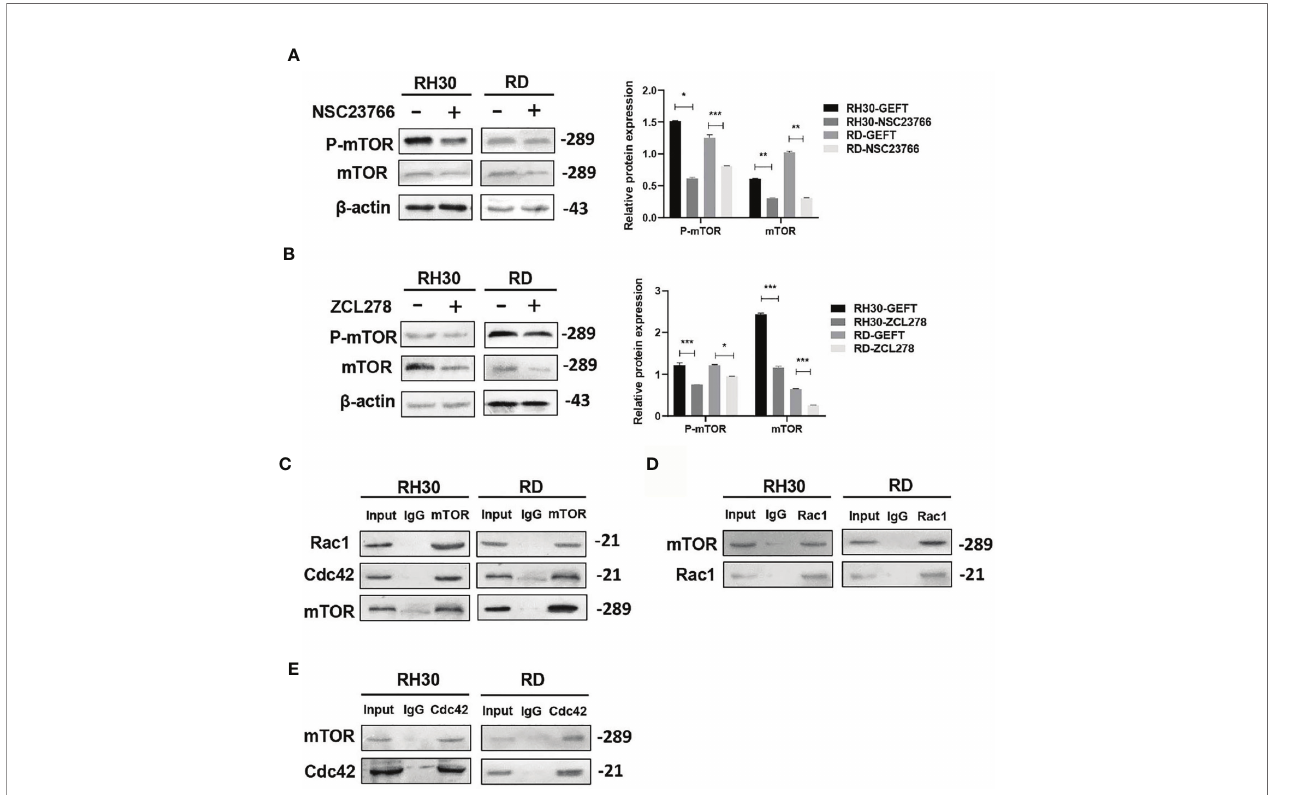
FIGURE 5 | mTOR can be regulated by Rac1/Cdc42. (A, B) The Rac1 (A) and Cdc42 (B) inhibitors were added to the RMS cells. p-mTOR and mTOR were detected by Western blot, and b -actin was used as a control. (C) The Rac1 and Cdc42 antibodies were used to pull down mTOR by using the co- immunoprecipitation assay. (D, E) . Rac1 (D) and Cdc42 (E) were pulled down using the mTOR antibody, and the results were examined by Western blot. *** P < 0.001, ** P < 0.01, * P <